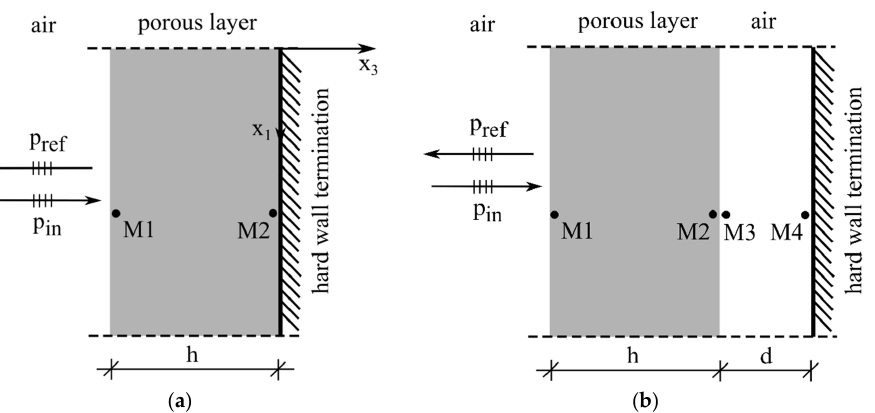
Figure 4. ( a ) TMM model of porous layer with rigid backing; ( b ) TMM model with porous layer and included air gap between the wall and the porous material.